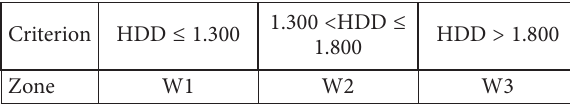
Table 2. Criterion for determining the winter climate zone Criterion HDD ≤ 1.300